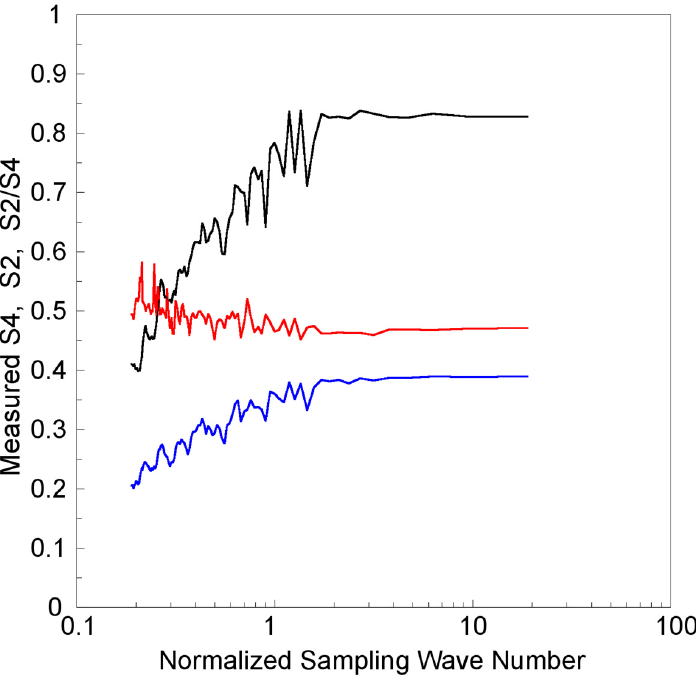
Figure 5. The dependence on normalized sampling wave number κ s / κ F for peak S 4 (in black), S 2 (in blue), and their ratio S 2 /S 4 (in red). The experimental amplitude data are the same as those used in Figure 4.